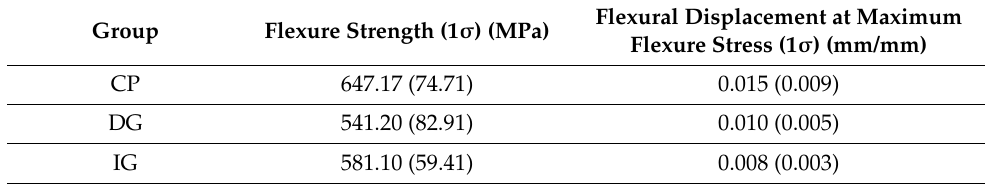
Figure 3. SEM images showing surface texture at 250 × (group CP, DG and IG). Note the nonglazed surface appear rougher compared to glazed surfaces. Table 4. Flexural strength and flexural displacement median values with standard deviation.